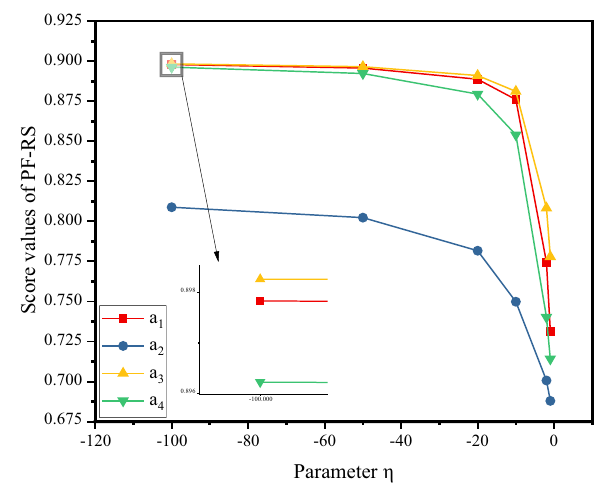
Fig. 4 Score values of the alternative using PF-RS for different η